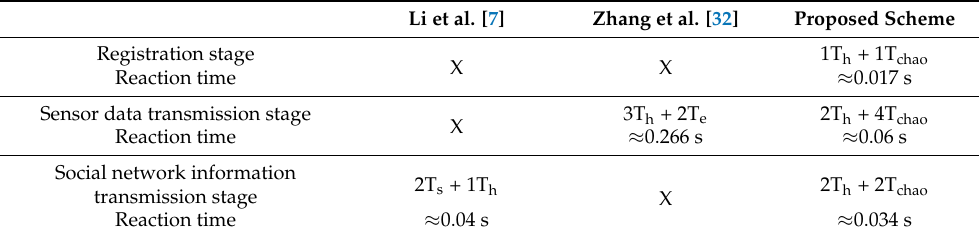
Table 3. Comparison table of calculation amount.